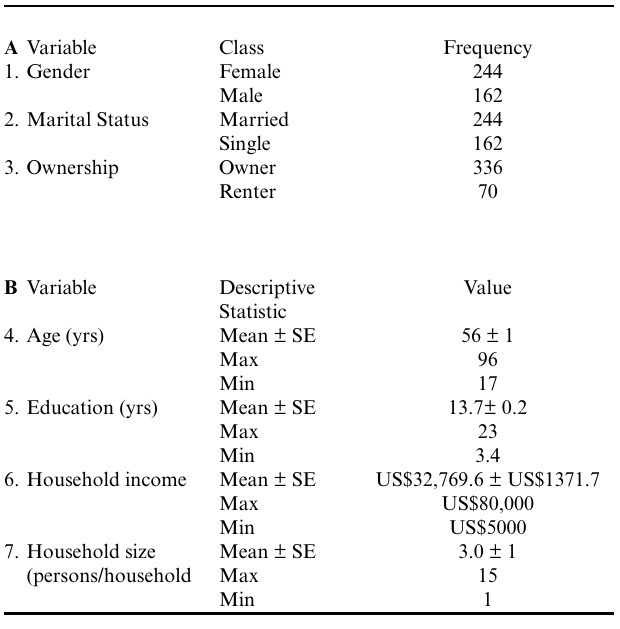
Table 1 . Descriptive statistics for social-economic characteristics of households at the Río Piedras